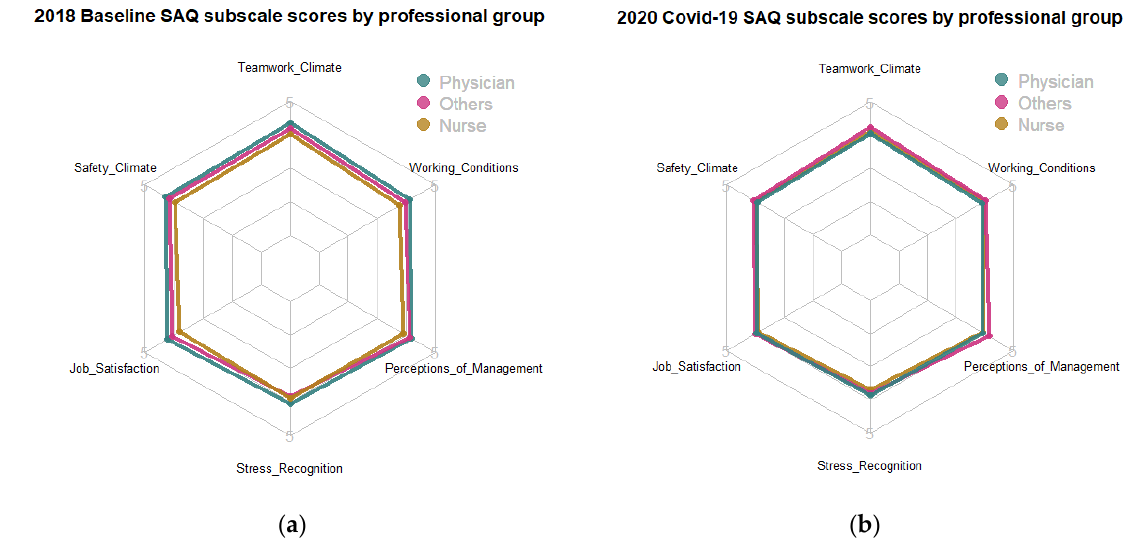
Figure 1. Radar plot: ( a ) 2018 baseline SAQ subscale scores by the professional group and ( b ) 2020 COVID-19 SAQ subscale scores by the professional group.